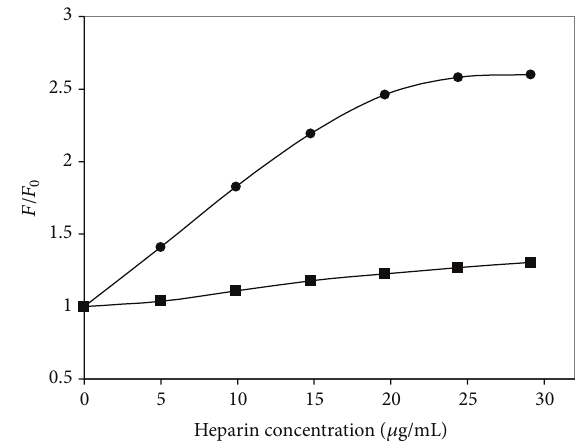
Figure 5: Plot of the luminescence enhancement ratio ( 𝐹/𝐹 0 ) of ( ∙ ) [Os(phen) 2 CO(py)](PF 6 ) 2 and ( ◼ ) [Os(phen) 2 CO(PPh 3 )](PF 6 ) 2 (Ex slit width: 5nm) both at 2.4 mg/100mL versus heparin concen-